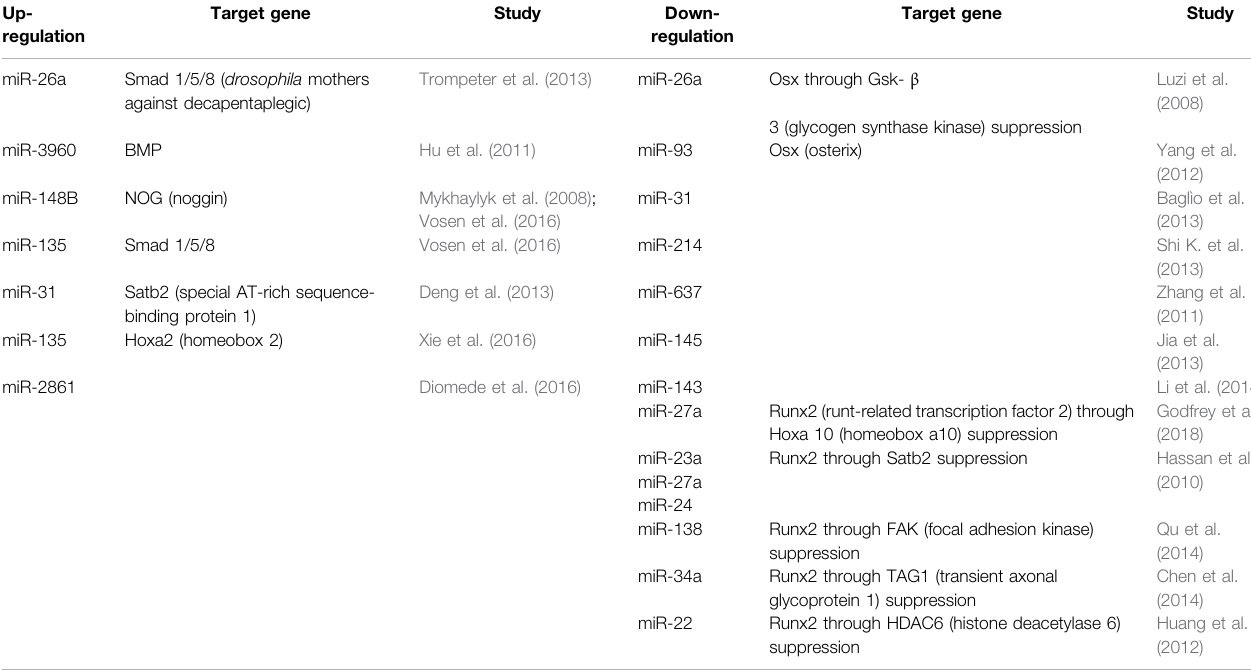
TABLE 3 | List of miRNA and role in osteogenesis differentiation in MSCs cells modulated by miRNA scaffold therapy.